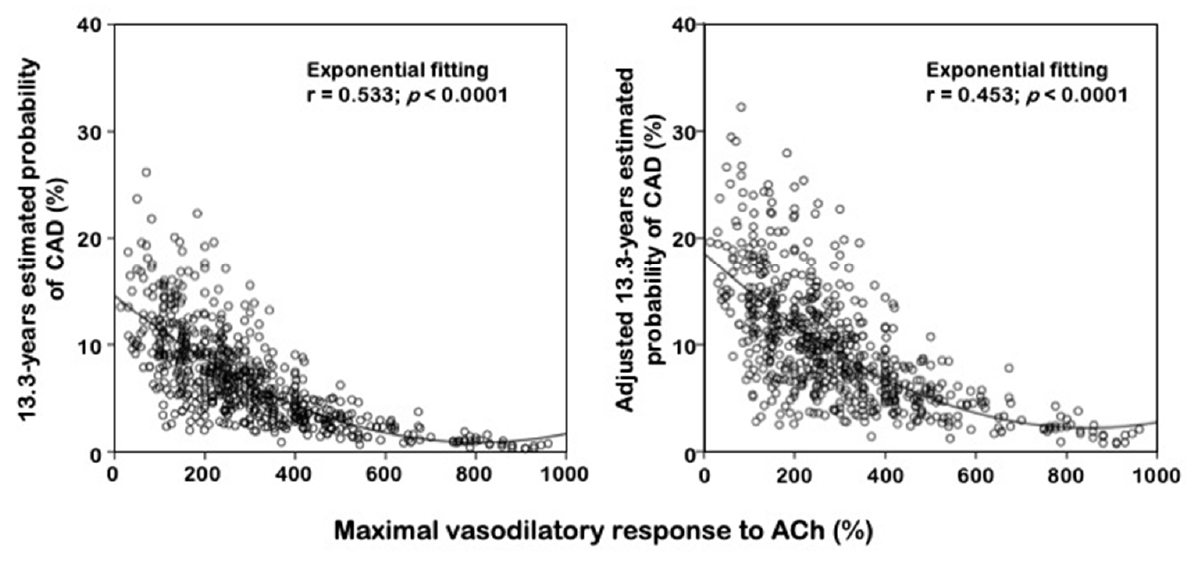
Figure 1. Relationship between endothelium function and risk of cardiovascular events. We graphically reported the relationship, expressed as an exponential fitting curve, crude and adjusted, between maximal vasodilatory response to acetylcholine (Ach) and probability of incident cardiovascular occurrence. Adjusted for age, systolic blood pressure, HDL-cholesterol, HOMA-index, e-GFR, and hs-CRP. Similarly, sodium nitroprusside infusion induced (Table 1) a significant increase in FBF (maximal increment from the basal, +317%) and a decrease in vascular resistance ( −